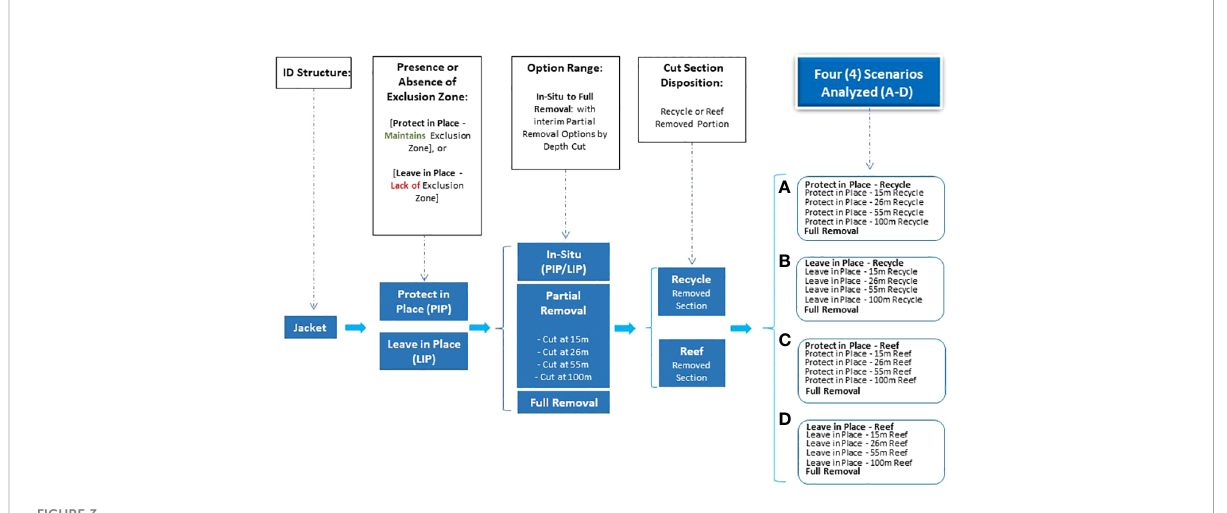
FIGURE 3 The NEBA-CA North Sea Jacket Option